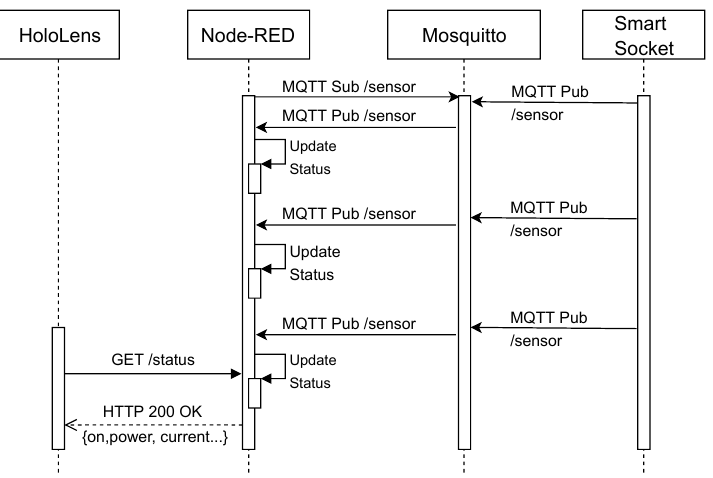
Figure 11. Sequence diagram for obtaining the status of the smart